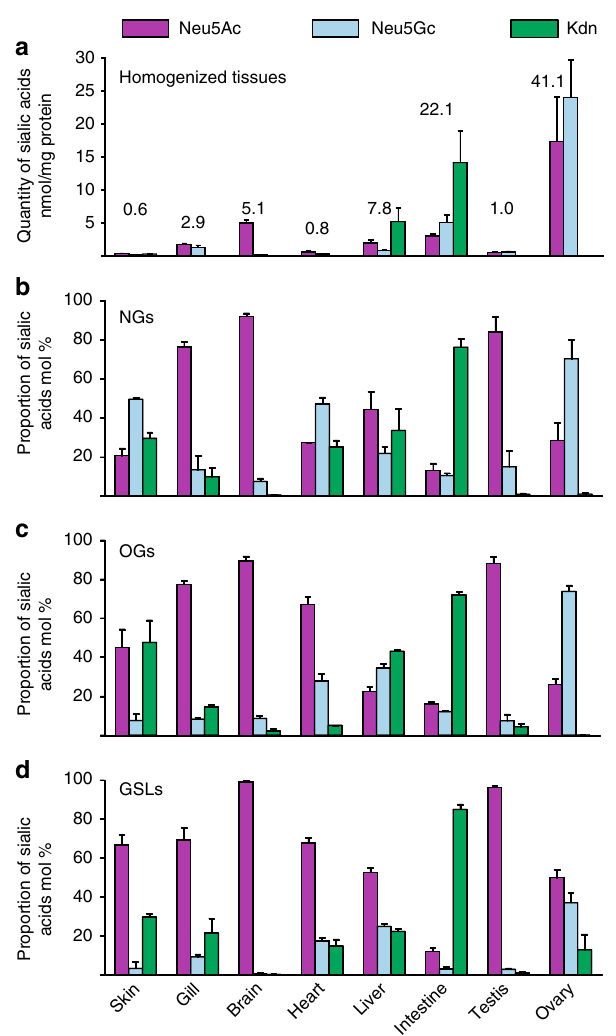
Fig. 2 Sialic acids composition. Individual sialic acids were identi fi ed and quanti fi ed by NP-HPLC-FL and LC – MS analysis of ( a ) total tissues, as well as puri fi ed ( b ) NGs, ( c ) OGs, and ( d ) GSLs. In total tissues ( a ), quantities were expressed as nmol of sialic acids per mg of proteins. In puri fi ed glycans ( b – d ), proportions of individual sialic acids were expressed in mol% because the yield of glycan puri fi cation from total tissues cannot be precisely established. Purple bar, Neu5Ac; blue bars, Neu5Gc; green bars, Kdn. Data are shown as mean ± SE of at least three (NG90), and 0:2 (NG91) ratios, respectively. In contrast, the core fucosylated equivalent of NG89 (NG92) could only be identi fi ed in low amount in the skin.